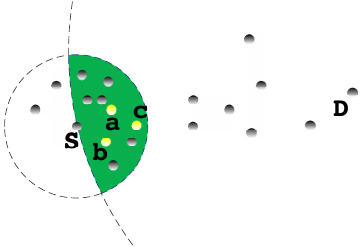
Figure 4. Energy and mobility greedy perimeter stateless routing (EM-GPSR) candidate set.